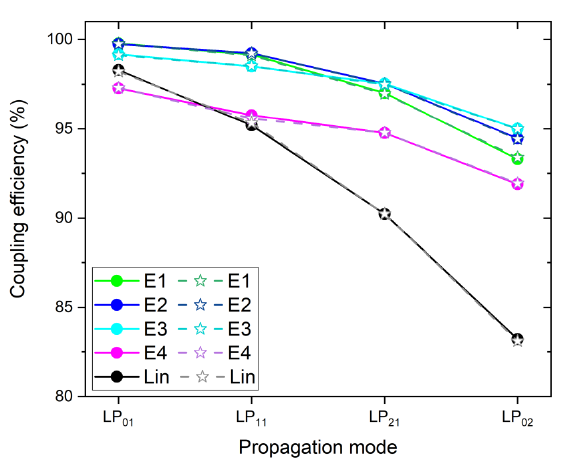
Figure 7. Modal coupling efficiency for all possible interconnecting structures designed for specific LP modes, analyzing the MFDs at the boundary of the interconnecting structure and FMF by means of the overlap